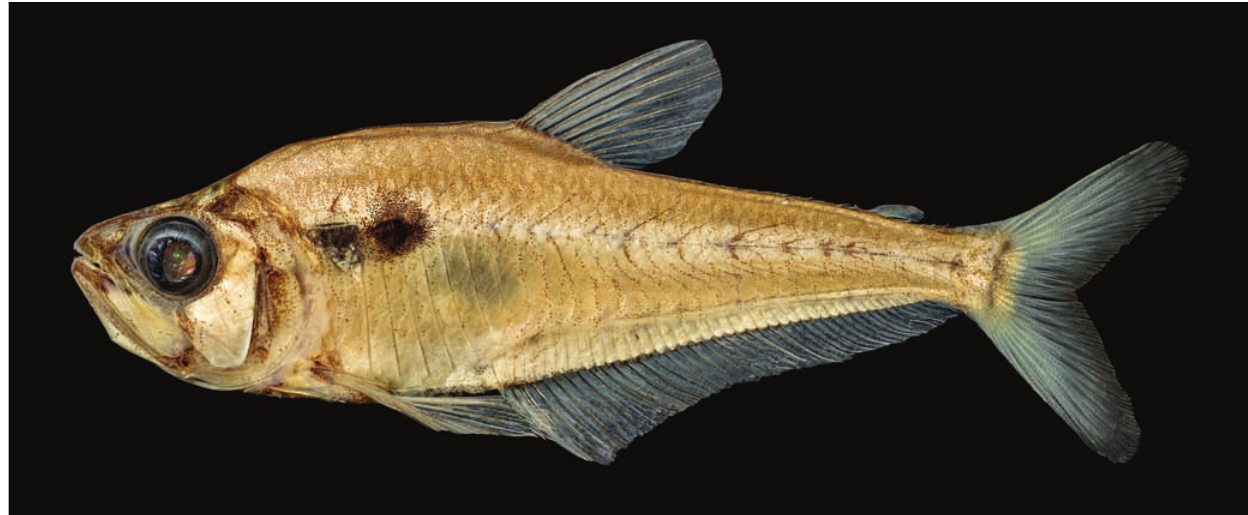
Fig. 9. Charax condei , MZUSP 95229, female, 49 mm SL, Amazonas, Santa Isabel do Rio Negro, pond on bank of rio Negro.